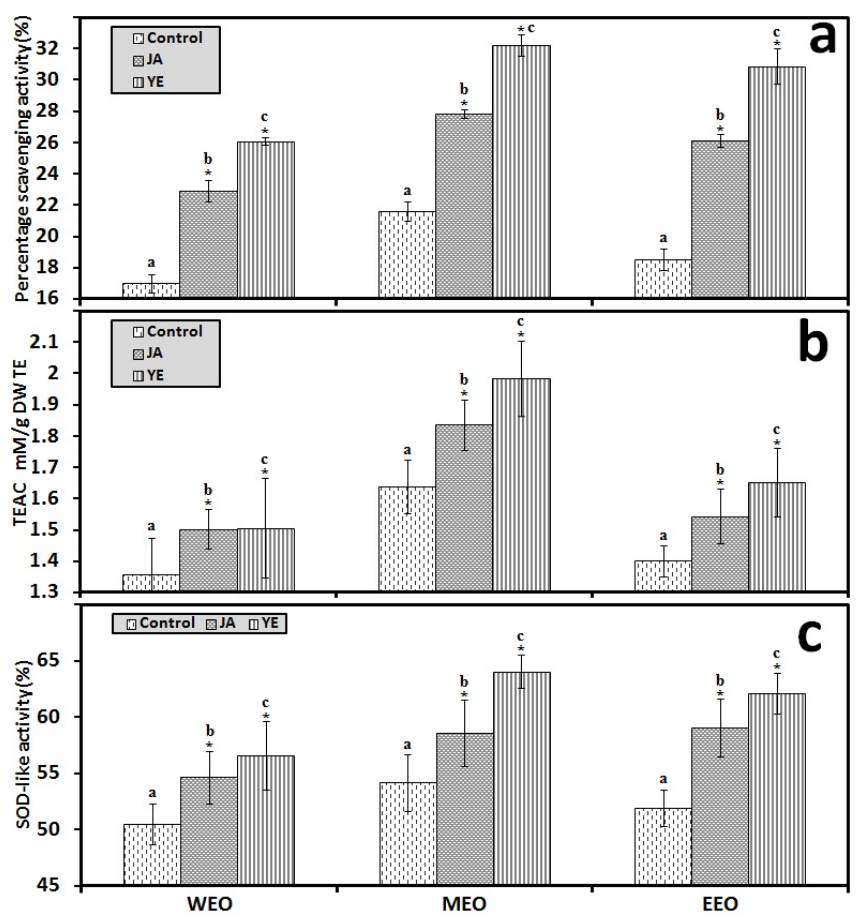
Figure 2. Antioxidant activity of the IOSC subjected to elicitation using three different solvents ( a ) DPPH scavenging activity; ( b ) TEAC antioxidant activity; and ( c ) SOD-like